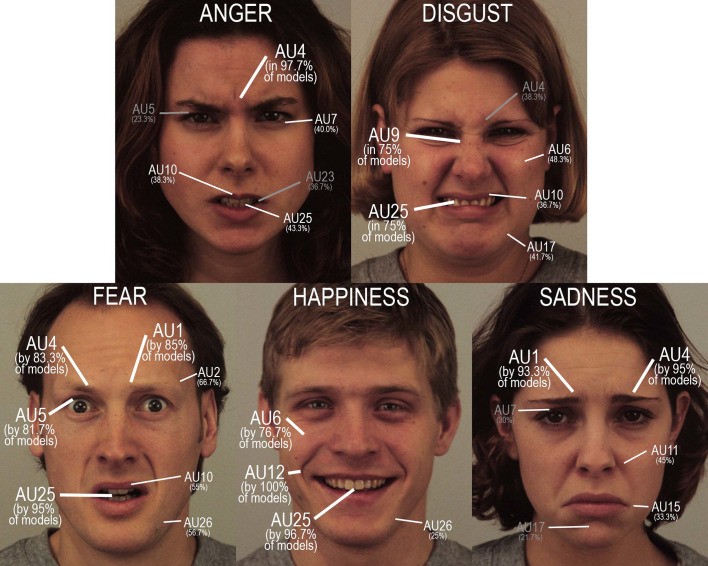
Illustration of the facial action units (AUs) that were used by the models to simulate the five emotions (with the example of the KDEF models, from the top to the bottom and from the left to the right: F29, F26, M10, M23 and F20).Their frequency is provided between brackets. AU1: inner brow raiser, AU2: outer brow raiser, AU4: brow lowerer, AU5: upper lid raiser, AU6: cheek raiser, AU7: lid tightener, AU9: nose wrinkler, AU10: upper lip raiser, AU11: nasolabial deepener, AU12: lip corner puller, AU15: lip corner depressor, AU17: chin raiser, AU23: lip tightener, AU25: lip part, AU26: jaw drop.